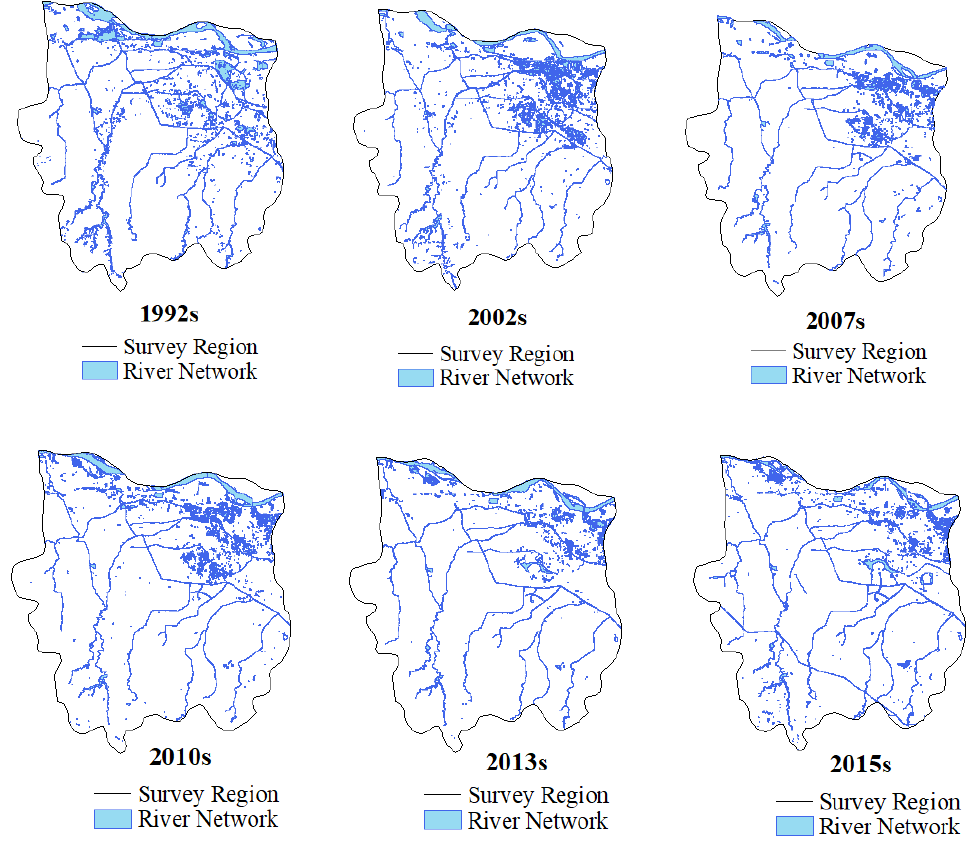
Figure 3. Schematic diagram of river network evolution in Zhengzhou in various periods.